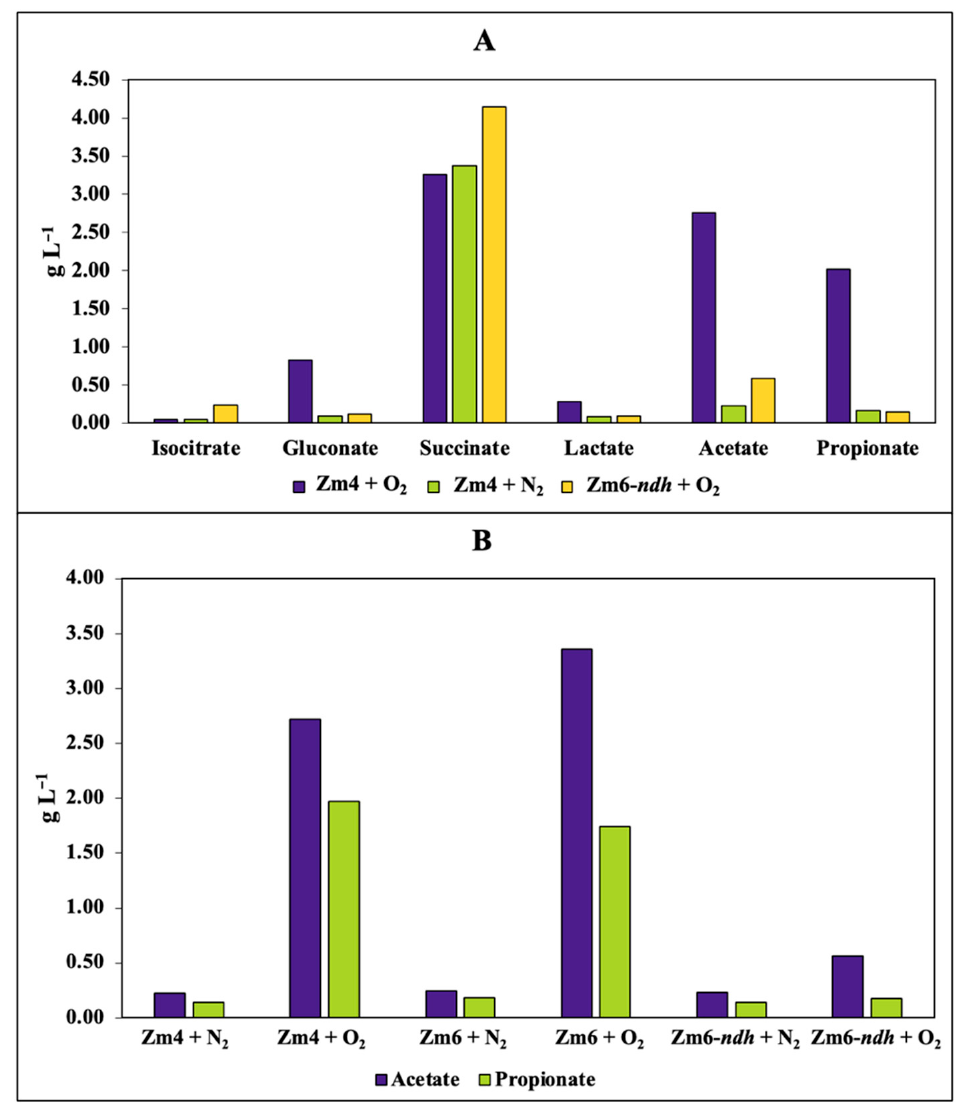
Figure 6. Acid byproducts in Z. mobilis stationary-phase batch cultures: ( A ) accumulation of acids in aerobically vs. anaerobically cultivated strain Zm4 and aerobically grown respiratory mutant Zm6- ndh ; ( B ) dependence of acetate and propionate accumulation on aeration in the strains Zm4, Zm6, and Zm6- ndh . Representative results of one experiment in a series are